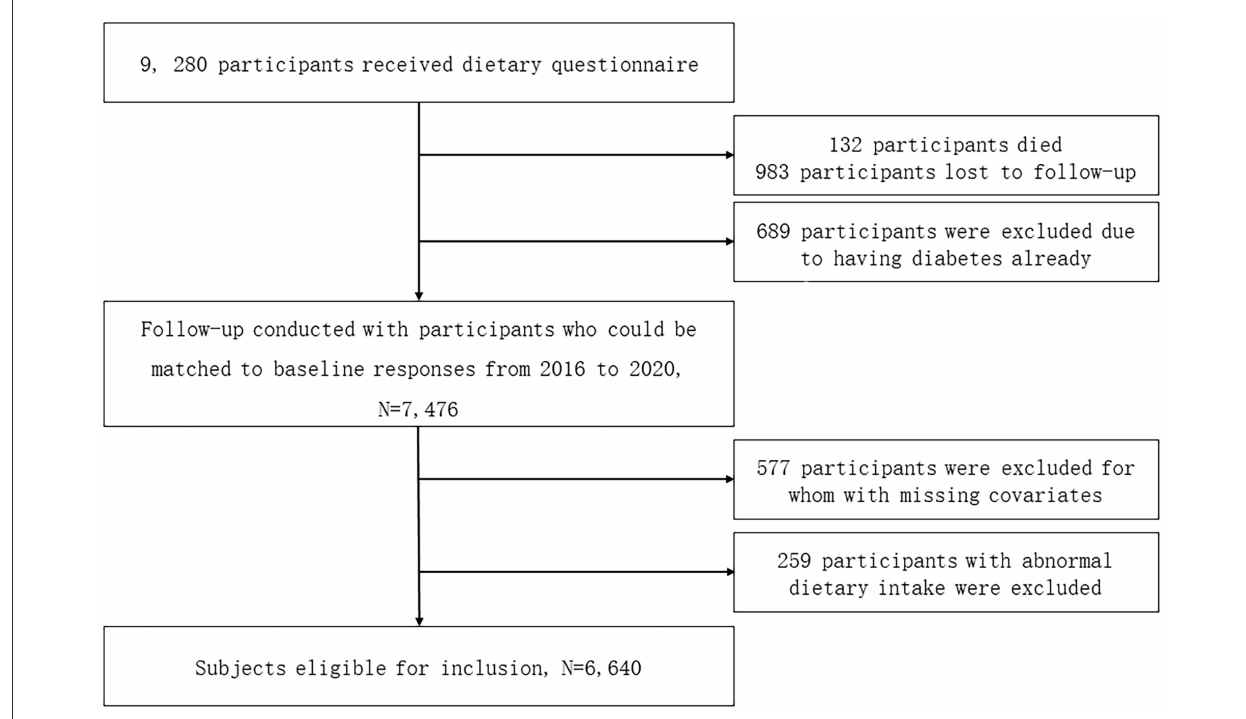
FIGURE1 Flow chart showing participant recruitment and data collection. Of the 9,280 participants recruited, 689 were excluded due to having diabetes at baseline. In addition, 983 participants were lost to follow-up, 132 died, 577 were excluded due to missing covariable data, and 259 were excluded for abnormal dietary practices. Therefore, analyses were conducted on data from 6,640